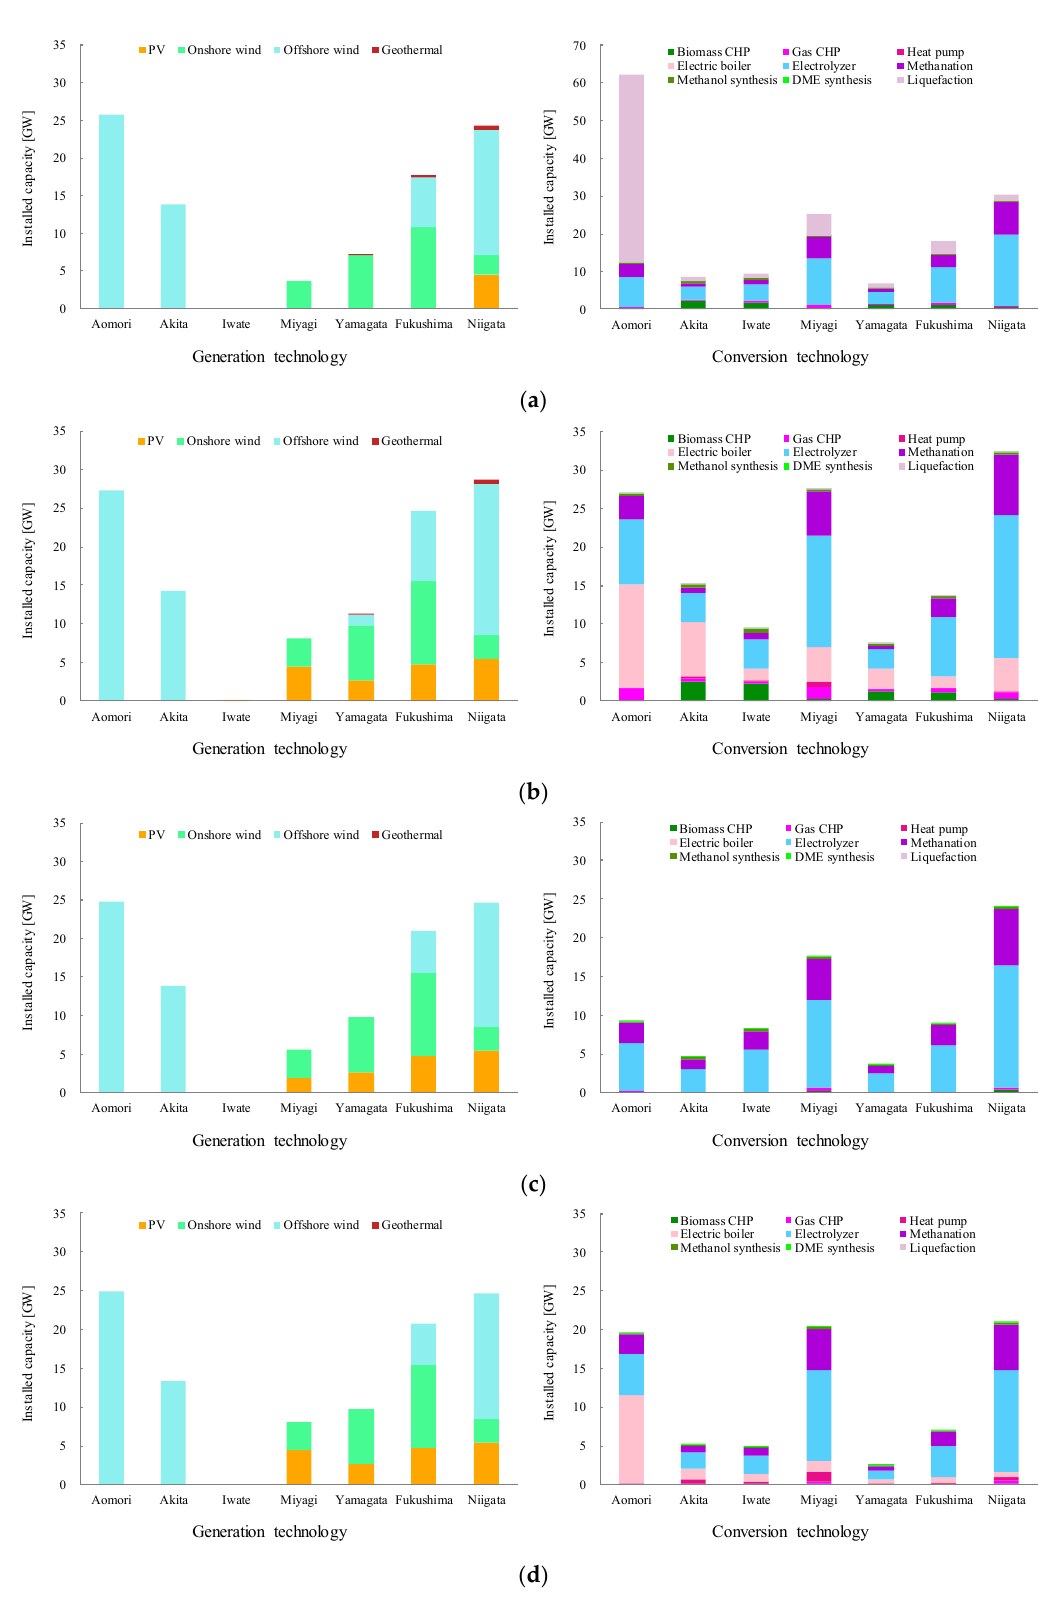
Figure 4. The optimal installed capacity of each technology. ( a ) All-BEV_IND scenario. ( b ) All-BEV_HD120 scenario. ( c ) All-BEV-V2G_IND scenario. ( d ) All-BEV-V2G_HD120